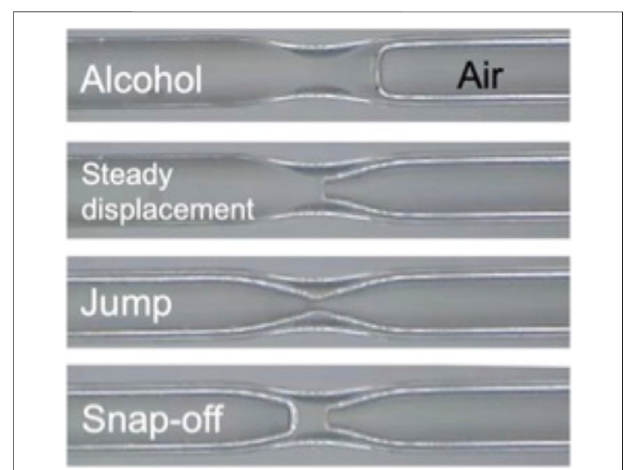
( Figure 4 — Note: a deformable solid matrix implies mechanical coupling with the mineral skeleton). Then, displacement-dependent capillarity couples with pressure- dependent volume change to cause “ jump ” instabilities